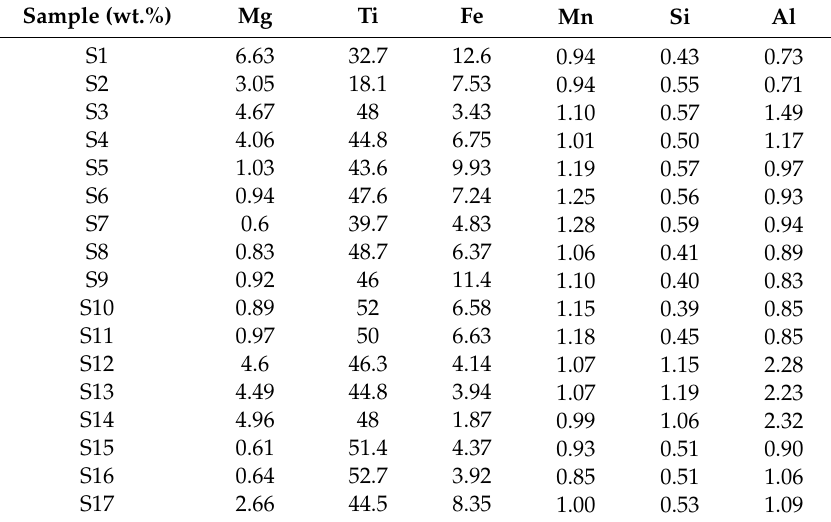
Table 1. The concentration of analytes in slag samples analyzed by ICP-OES. Sample (wt.%)